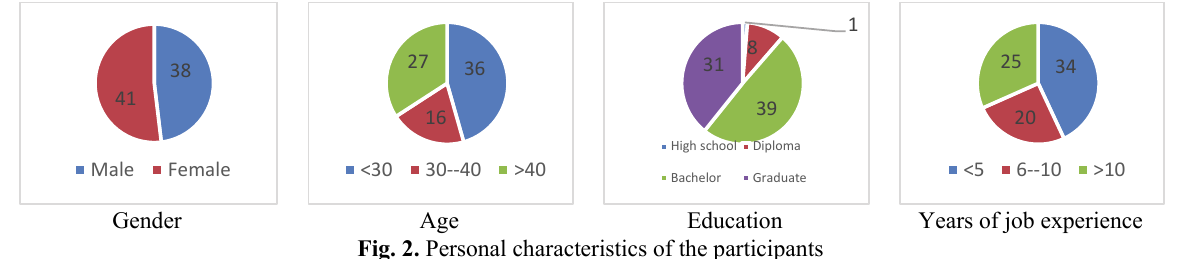
Fig. 2. Personal characteristics of the participants